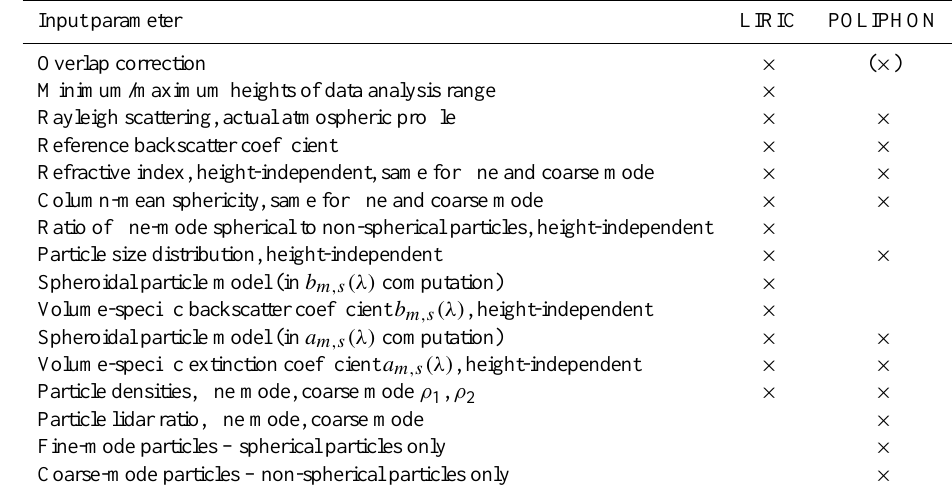
Table 1. Atmospheric and lidar input parameters and assumptions in the LIRIC and POLIPHON mass concentration retrievals as used in the paper. Overlap correction has only an impact on POLIPHON results for heights with O(λ j ,z i ) < 1. Input parameter LIRIC POLIPHON Overlap correction × ( × ) Minimum/maximum heights of data analysis range × Rayleigh scattering, actual atmospheric profile × × Reference backscatter coefficient × × Refractive index, height-independent, same for fine and coarse mode × × Column-mean sphericity, same for fine and coarse mode × × Ratio of fine-mode spherical to non-spherical particles, height-independent × Particle size distribution, height-independent × × Spheroidal particle model (in b m,s (λ) computation) × Volume-specific backscatter coefficient b m,s (λ) , height-independent × Spheroidal particle model (in a m,s (λ) computation) × × Volume-specific extinction coefficient a m,s (λ) , height-independent × × Particle densities, fine mode, coarse mode ρ 1 , ρ 2 × × Particle lidar ratio, fine mode, coarse mode × Fine-mode particles – spherical particles only × Coarse-mode particles – non-spherical particles only